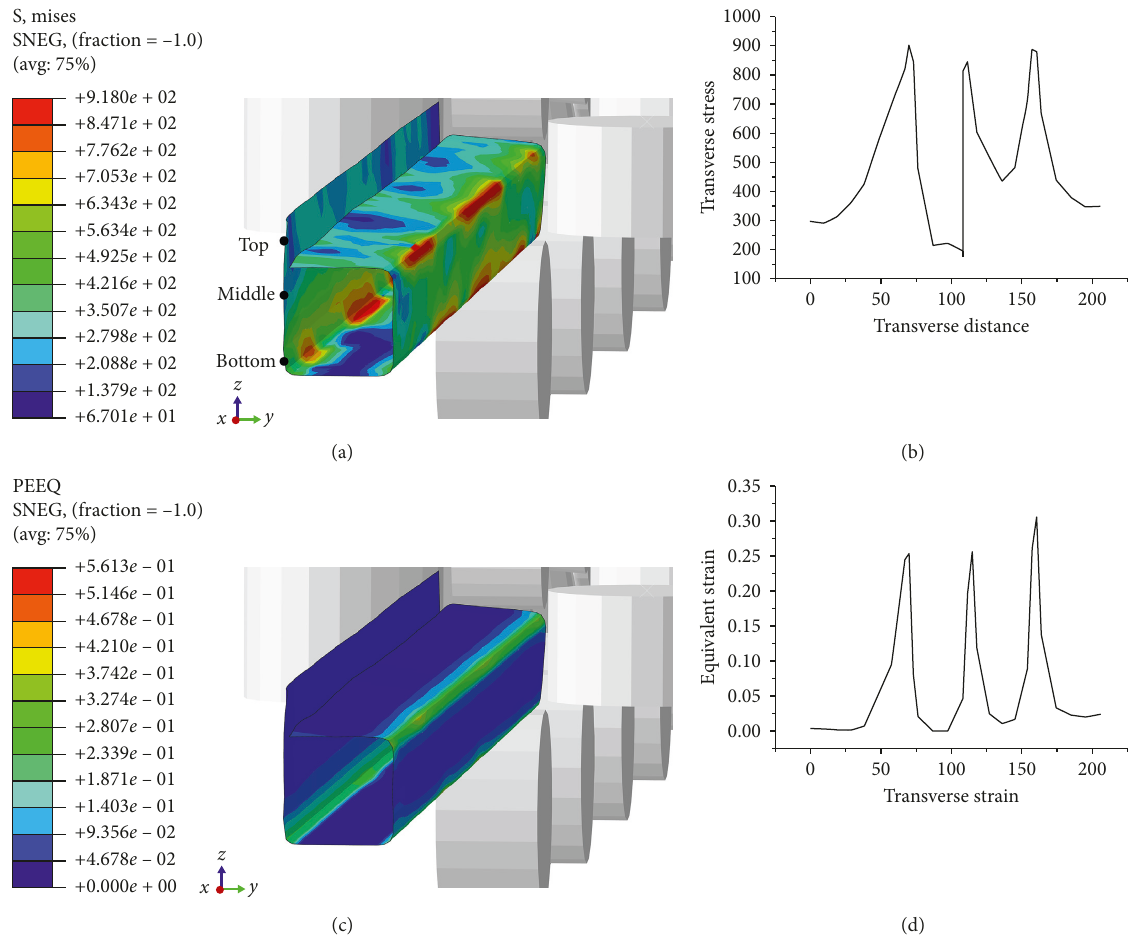
Figure 13: (a) Mises stress distribution diagram of b-shaped tube. (b) Transverse stress of the sheet metal. (c) Equivalent strain distribution diagram of b-shaped tube. (d) Transverse strain of the sheet metal.